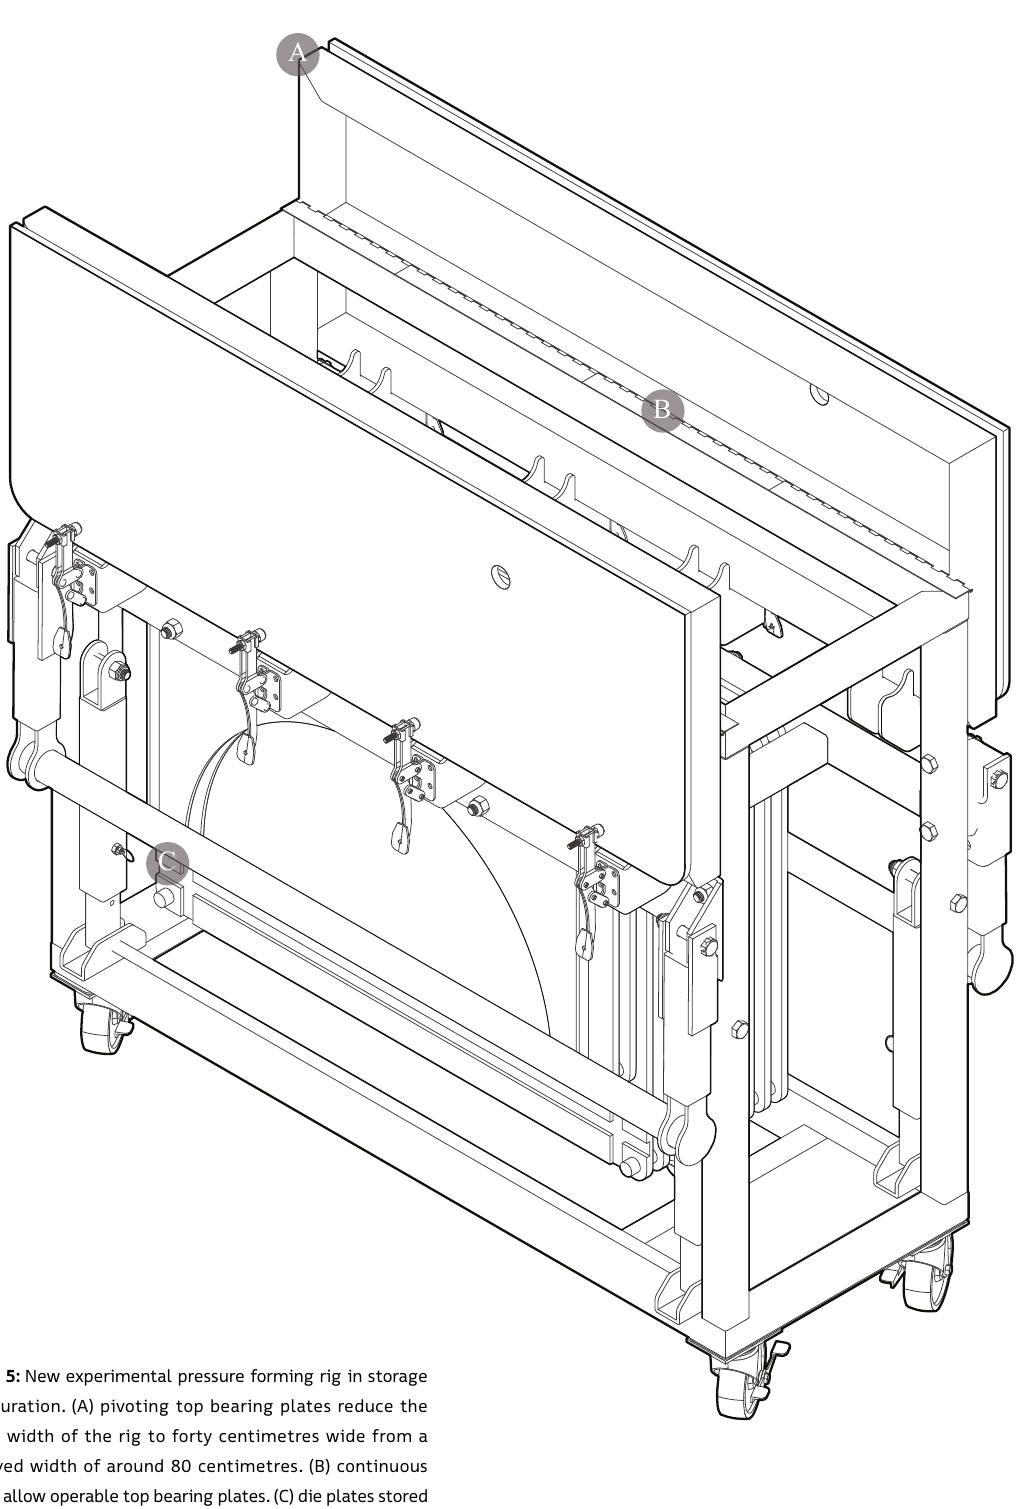
Figure 5: New experimental pressure forming rig in storage configuration. (A) pivoting top bearing plates reduce the stored width of the rig to forty centimetres wide from a deployed width of around 80 centimetres. (B) continuous hinges allow operable top bearing plates. (C) die plates stored underneath the rig support have rubber bumpers to prevent noise and vibration. Source: